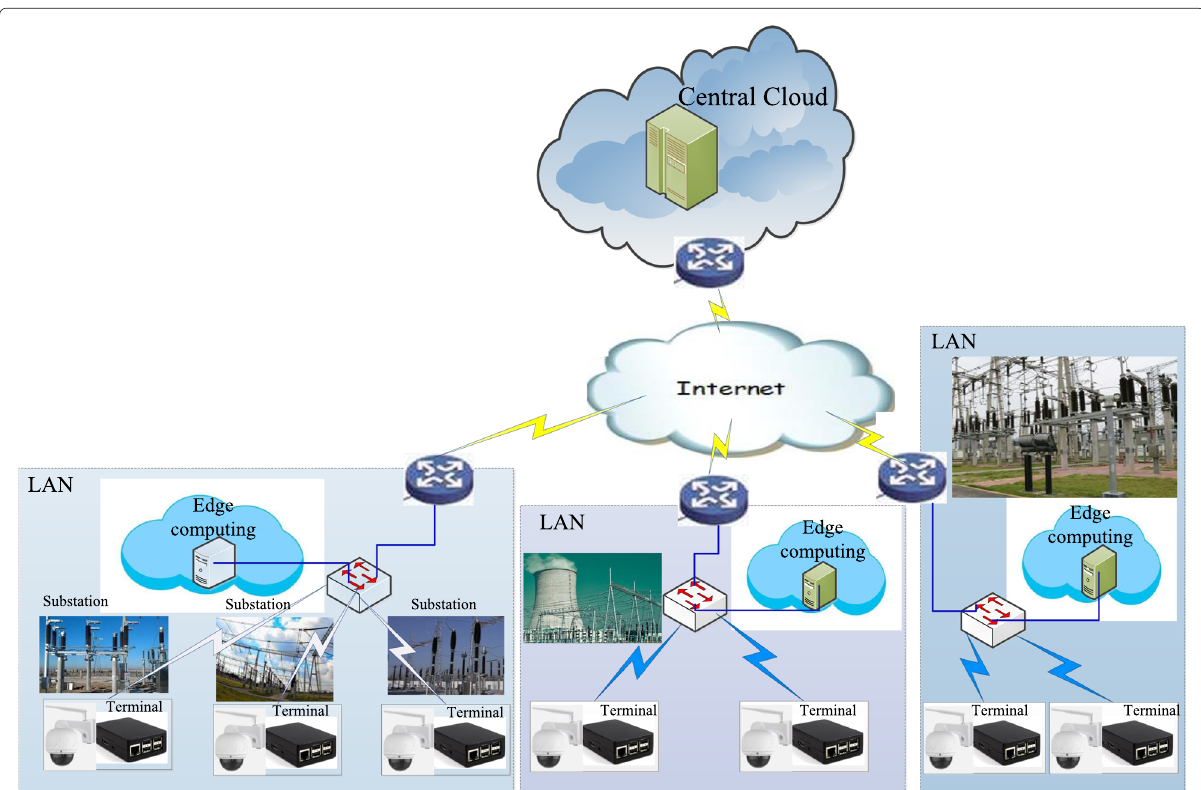
The video image acquisition and simple preprocessing part of video image are deployed to the perception ter- minal. When the continuous image frames with human motion are detected by the perception terminal, these images will be standardized and scaled, and the data will be sent to the local edge computing entity using the Message Queuing Telemetry Transport (MQTT) protocol. The decision service of unsafe action is deployed to local edge computing. When the unsafe action judgment entity at the edge receives the video image data sent by the terminal, it is handed over to the action recogni- tion model for action recognition, and the data is sent to Yolo model for equipment target detection. Based on the identification results and detection results, the